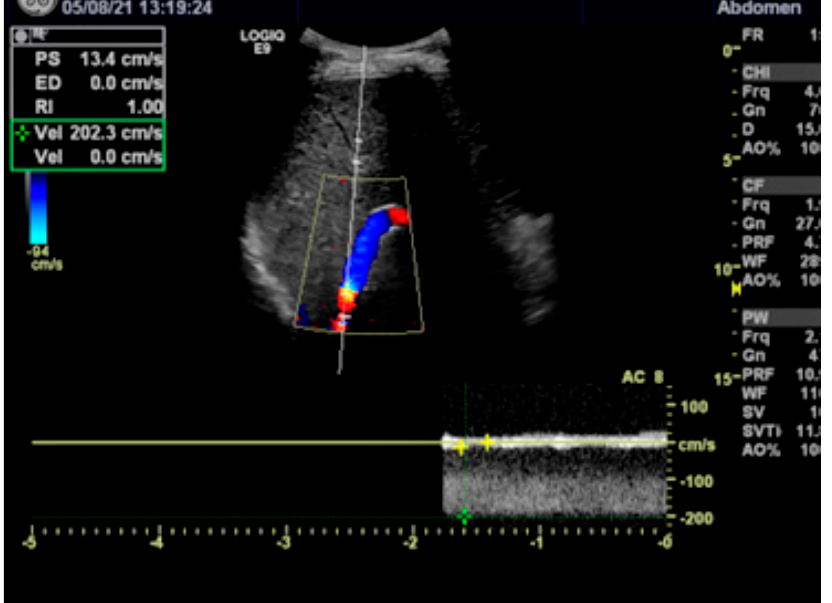
Figure 4. Duplex sonography showing stenosis in the proximal stent with a turbulent flow and a maximum flow velocity of 200 cm/s (2 m/s). According to the Bernouilli equation, the maximum flow velocity corresponds to a pressure gradient across the stenosis of 16 mmHg. Shunt failure is seen in about 25% of patients when covered stents are used [29,35– 37]. The problem can be solved by stent-in-stent implantation or by parallel stenting, achieving secondary long-term patency rates of 95% [29,31]. A parallel second TIPS may be necessary if the stent cannot be entered, as demonstrated in Figure 5.